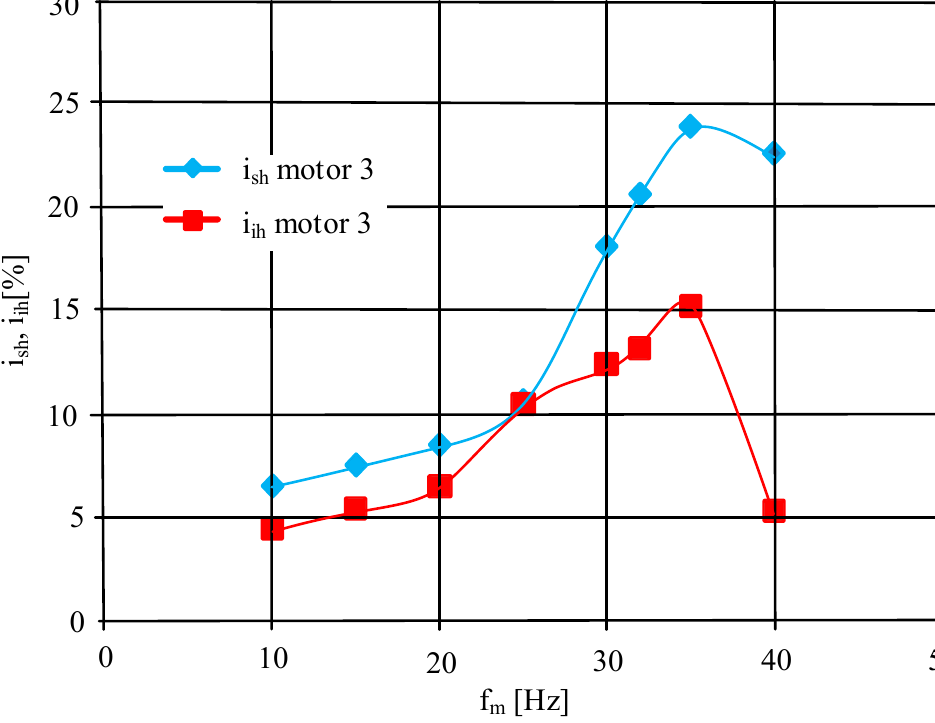
Figure 23. Measured current subharmonics and interharmonics versus the frequency of the amplitude modulation for Case B. The frequency components are related to the rated current.